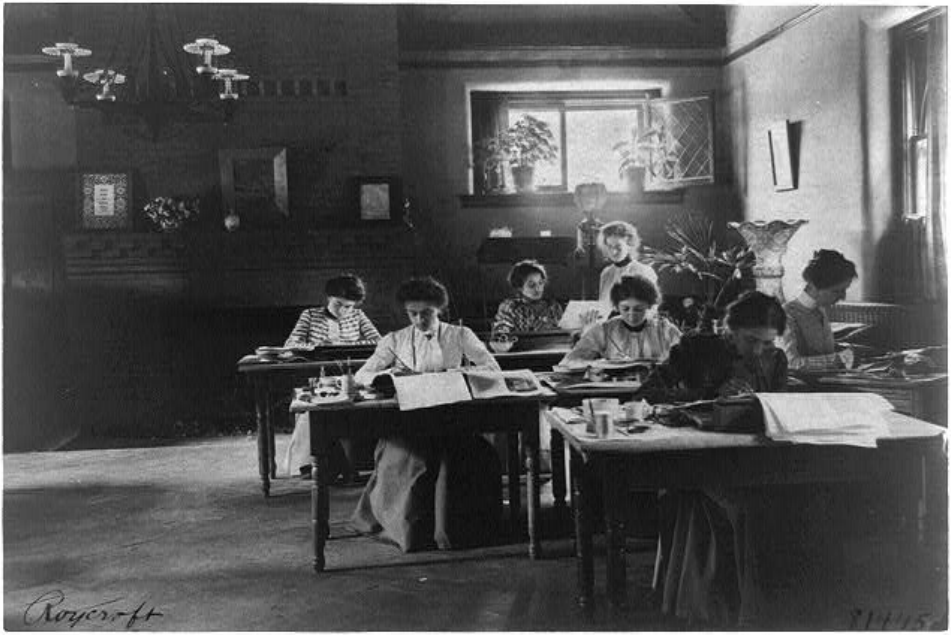
Figure 27. Frances Benjamin Johnston 1900. Seven women in the Roycraft Shop. Library of Congress.